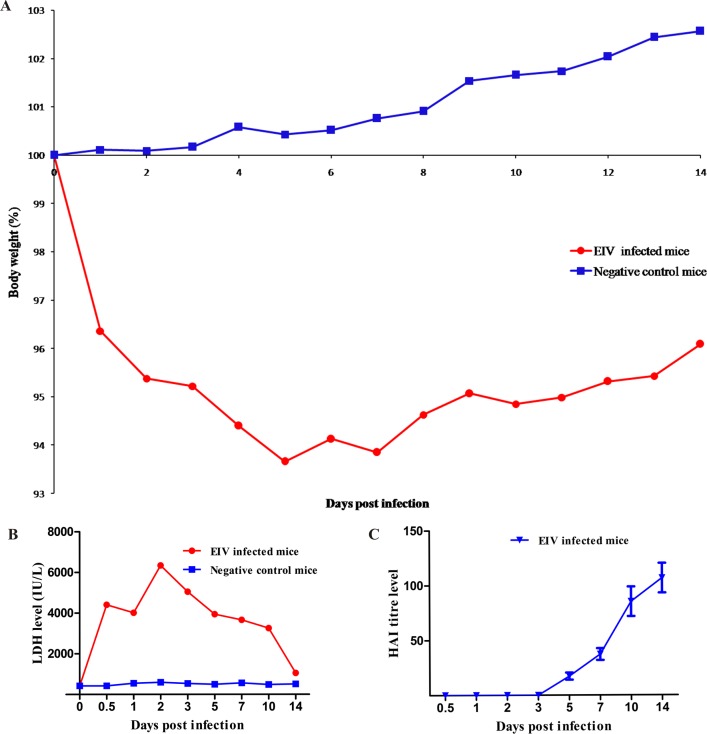
Pathogenicity of eq/J-K/08 H3N8 EIV in mice:
A:Percentage changes in body weight of EIV infected mice and negative control mice during the period of experiment (0–14 dpi). B:LDH level in pooled serum samples from EIV infected mice during the period of experiment. C:Humaral immune response following experimental EIV infection in BALB/c mice.